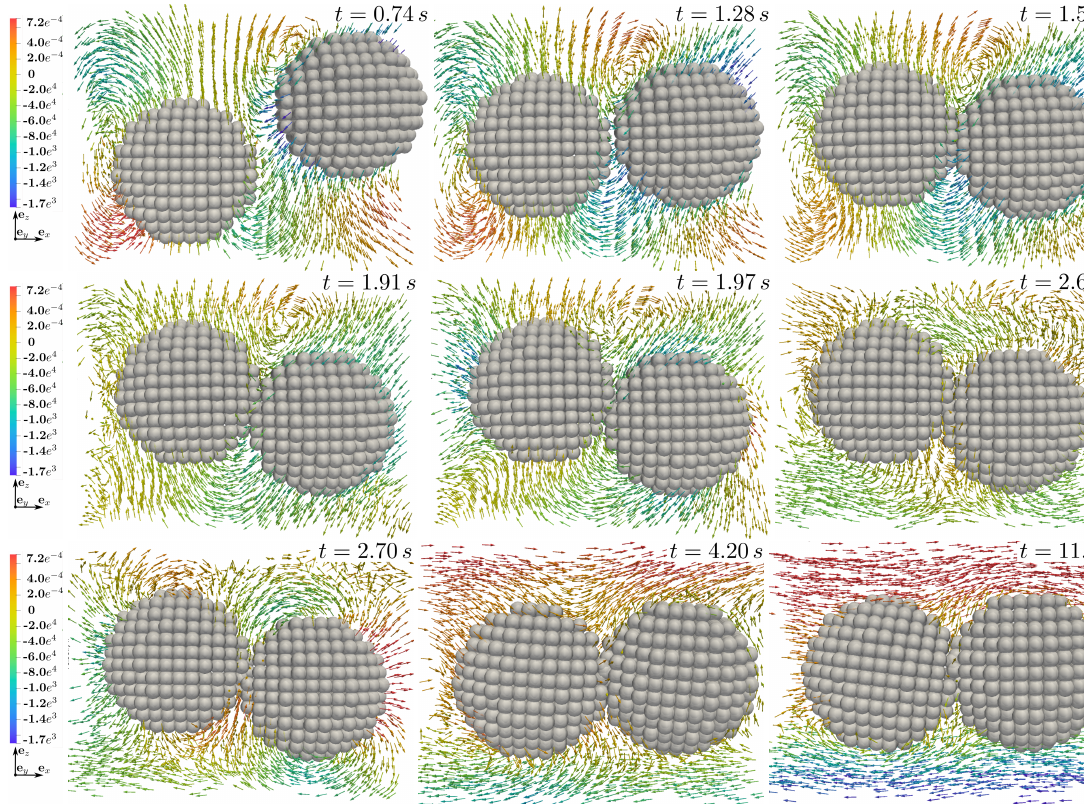
Figure 15. Velocity trajectories of v x for the evolution of contact between two solid particles over time (top left to bottom right). Contact occurs at t = 1.91s and again at t = 2.60s. Due to